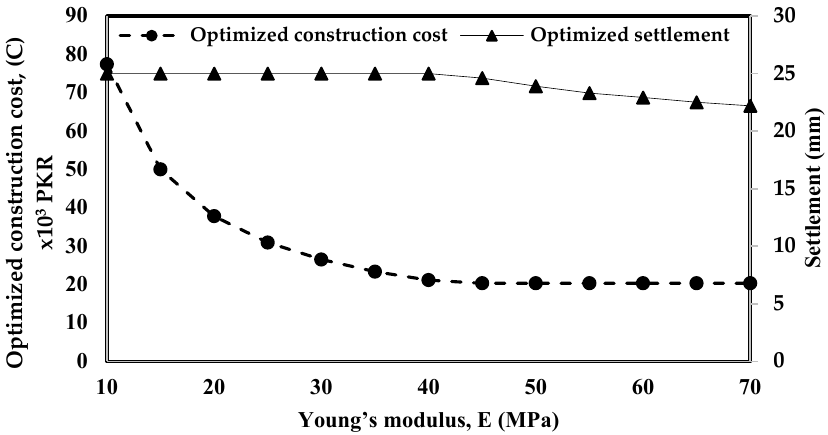
Figure 5. Effect of Young’s modulus on optimized construction cost.